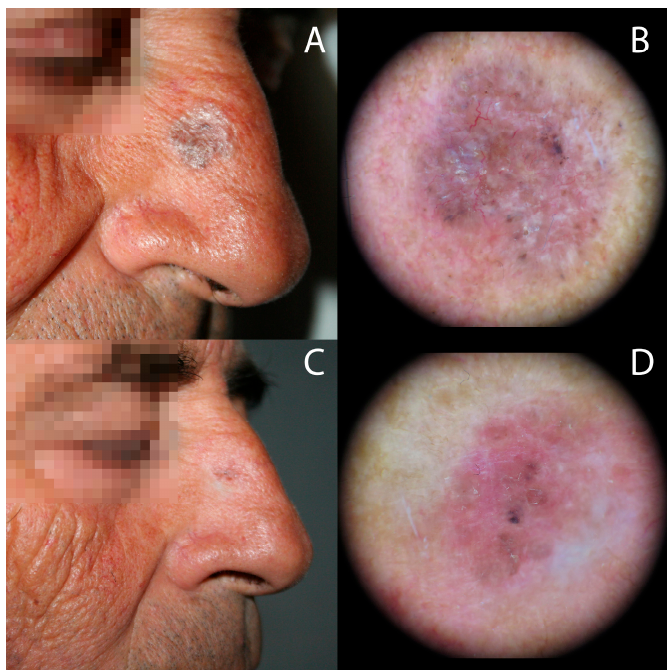
Figure 2. Superficial pigmented BCC at the right side of the nose treated with MAL-PDT using IPL as light source. Clinical and dermoscopic images showing: ( A , B ) arborizing telangectasias, large blue/gray ovoid nests, multiple blue/gray globules before treatment and ( C , D ) partial clinical and dermoscopic response, defined by a decrease of BCC-specific dermoscopic features with persistence of few arborizing telangectasias and blu/gray globules, at six months follow-up.